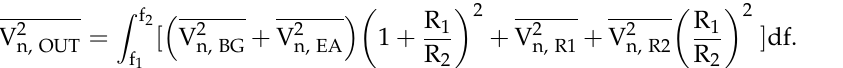
, equivalent input noise of the error amplifier (EAMP) V 2 n, BG